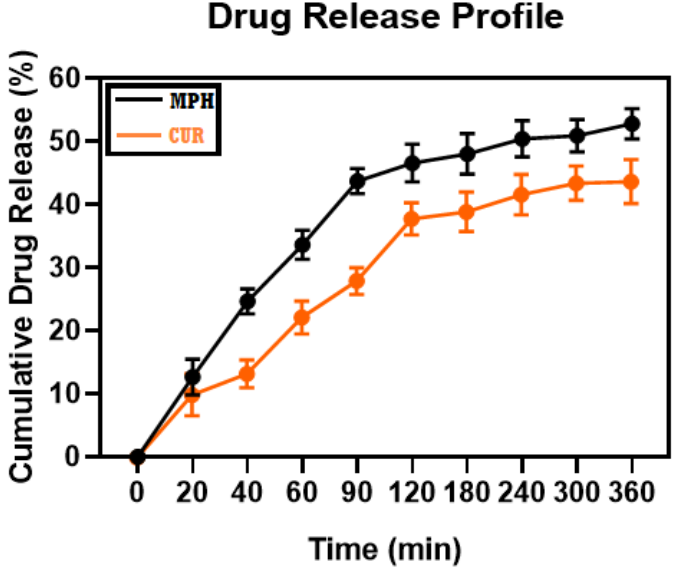
Figure A5. Release profiles of MPH and CUR from the cavities of NSs.